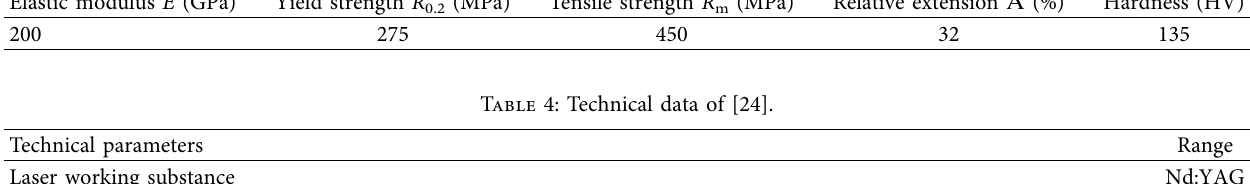
Table 3: Results of mechanical tensile tests of steel samples.